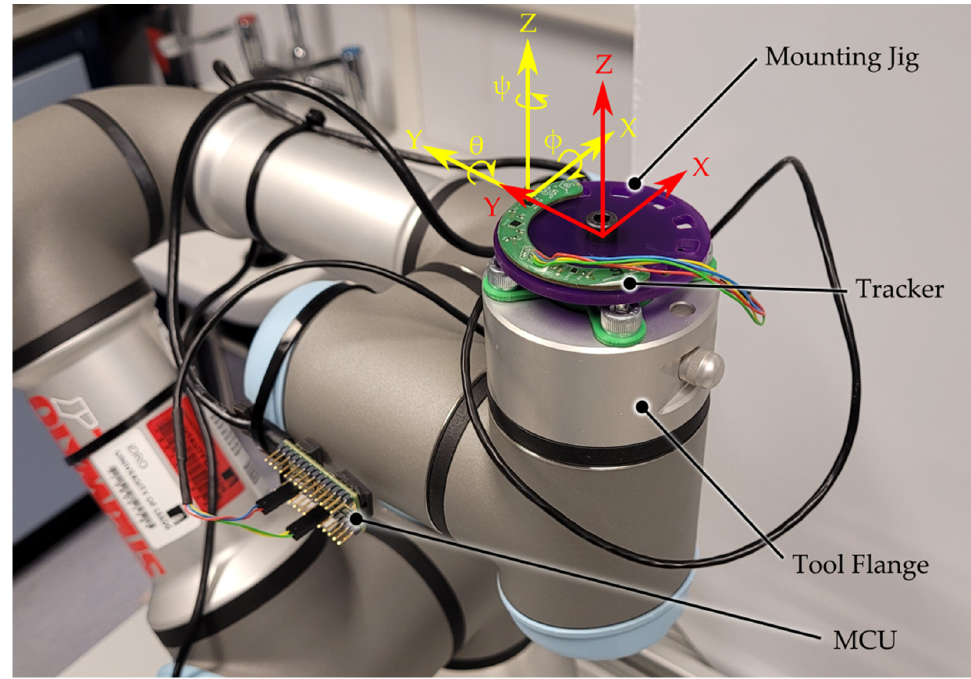
Figure 3. Labelled photograph showing the experimental setup of the tracking system on the tool flange of the robot arm. The yellow axes denote the IMU reference frame which, once fully calibrated, was aligned with the tool reference frame (red).